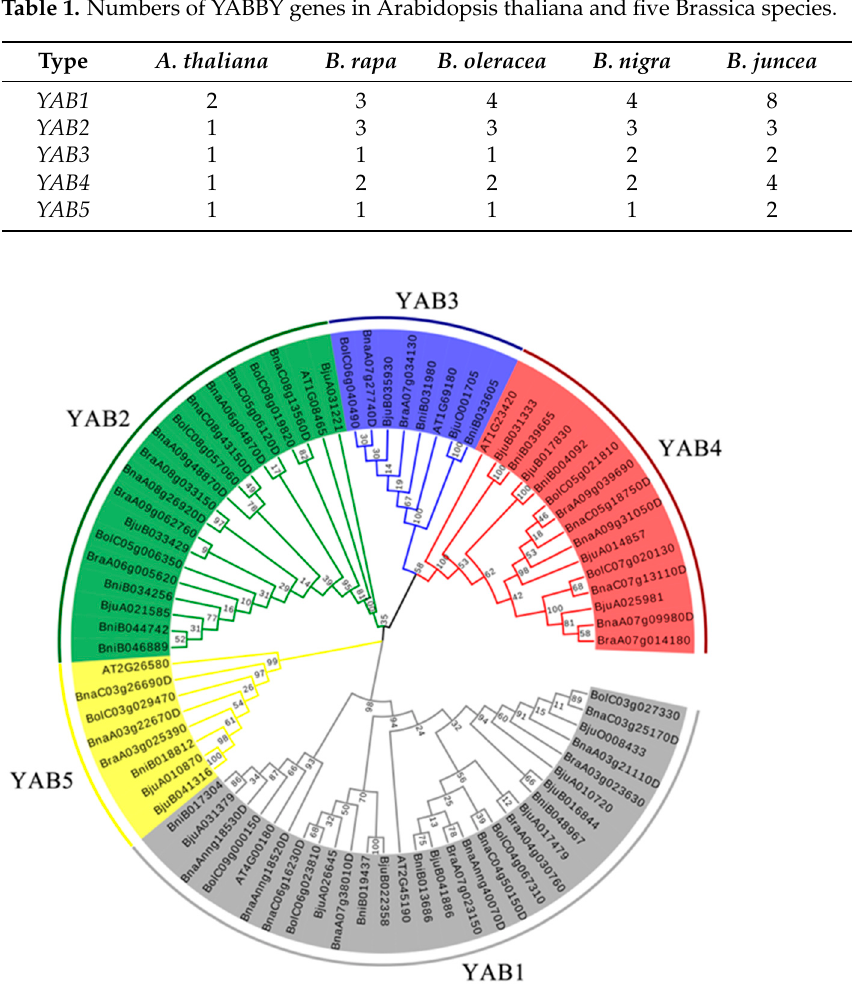
Figure 1. Phylogenetic tree of YABBY proteins from Arabidopsis and five Brassica species. YABBYs cluster into five subfamilies (YAB1–YAB5), indicated by different colors. Bju, Brassica juncea; Bna,